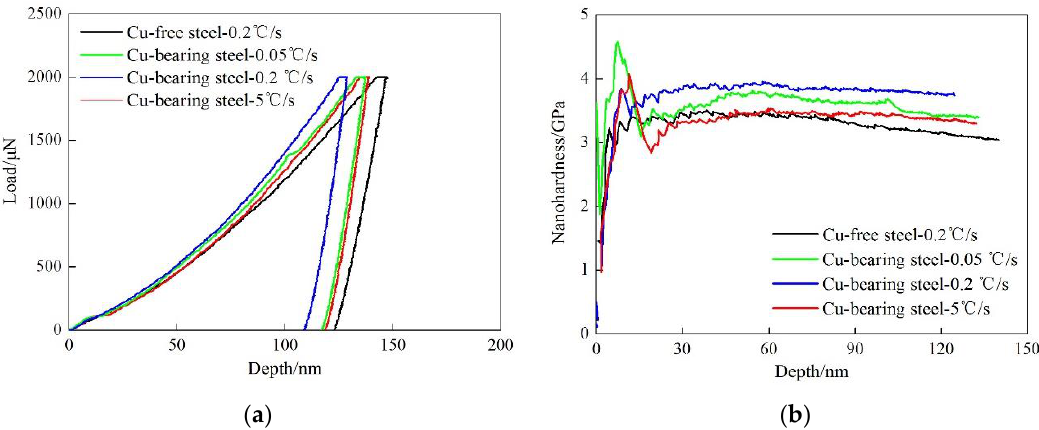
Figure 6. The experimental results of nano-indentation. ( a ) typical load-depth curves, ( b ) nano-hardness-depth curves.